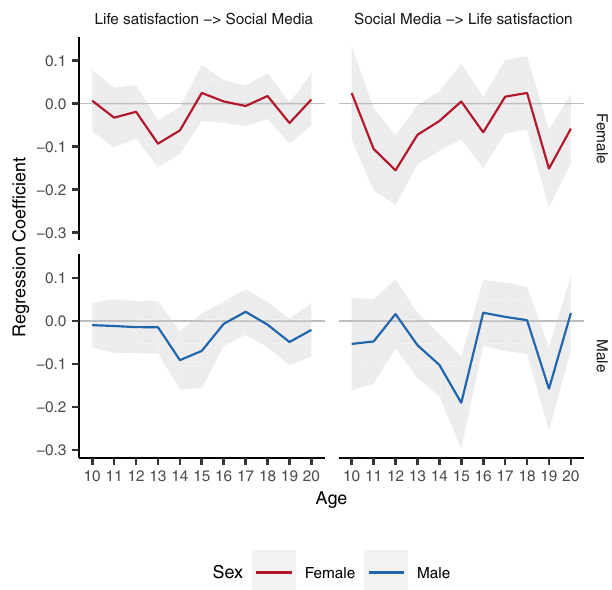
Fig. 3 Results from Random Intercept Cross-Lagged Panel Model (RI- CLPM) of estimated social media use and life satisfaction for 17,409 participants of the Understanding Society dataset aged 10 – 21 (52,556 measurement occasions). Results from both cross-lagged paths of a RI- CLPM where those paths were free to vary across age/sex. Results are unstandardized and split by path (left: deviations from expected ratings of life satisfaction at that age predicting deviations from expected social media use one year later; right: deviations from expected social media use at that age predicting deviations from expected ratings of life satisfaction one year later) and sex (female = top/red, male = bottom/blue). The ribbon represents the 95% Con fi dence Interval around the point estimate. All tests are two-sided. Source data for this fi gure are provided as a Source Data fi